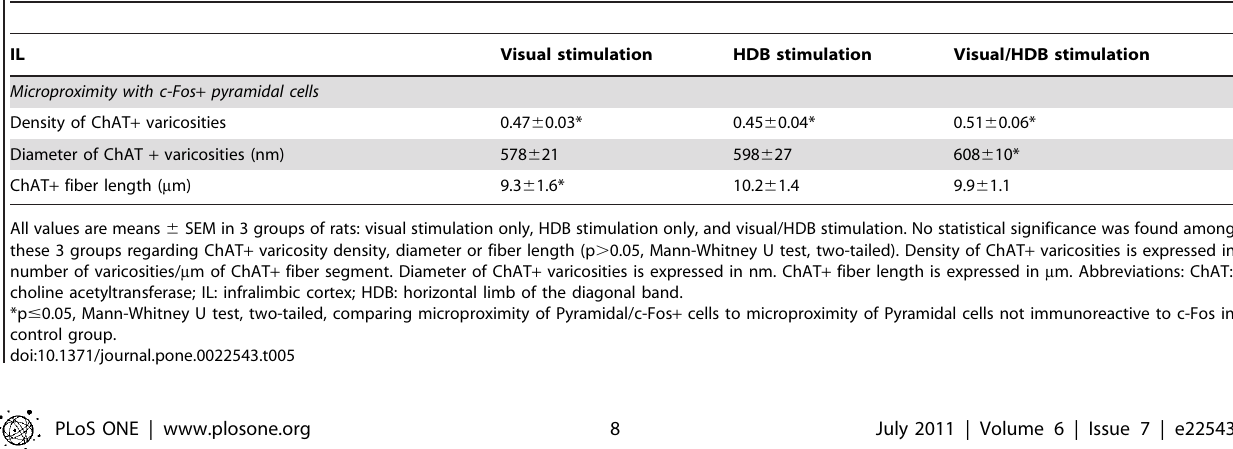
Table 5. Density and diameter of ChAT + varicosities and length of ChAT + fiber segments within microproximity of activated pyramidal cells in Layer V of IL.